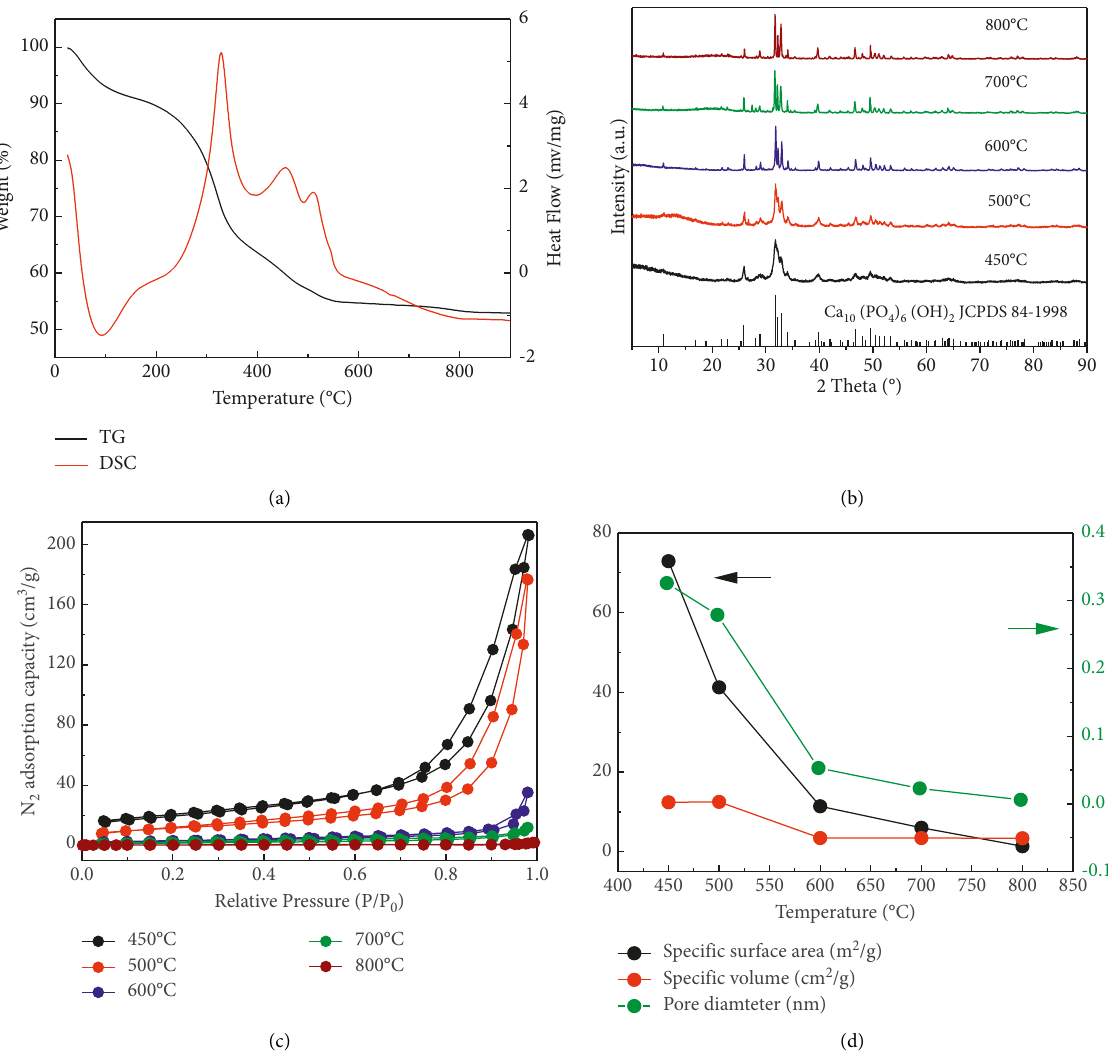
Figure 1: (a) TG-DSC curve of bovine bone. (b) XRD patterns of hydroxyapatite under different calcination temperatures. (c) N isotherms of hydroxyapatite under different calcination temperatures. (d) Surface parameters of hydroxyapatite under different calcination